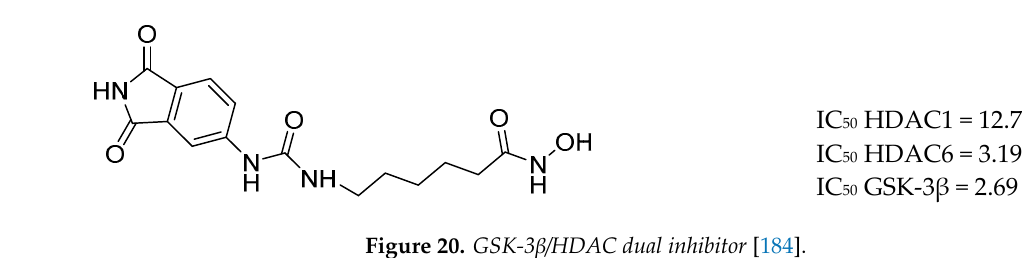
Figure 20. GSK-3 β /HDAC dual inhibitor [184] .